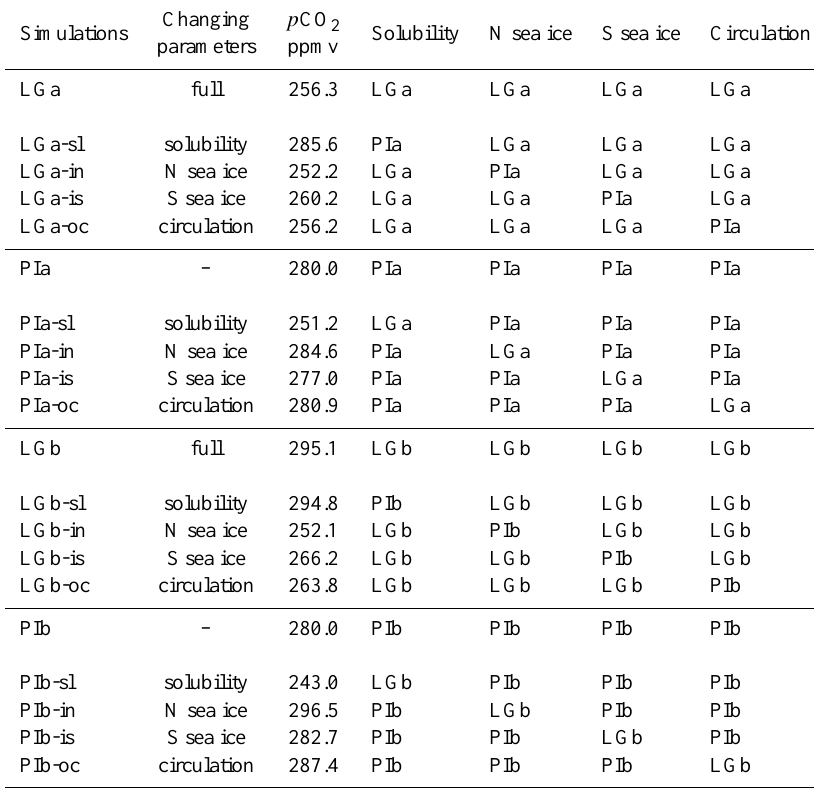
Table 1. Factorial experimental design and results.